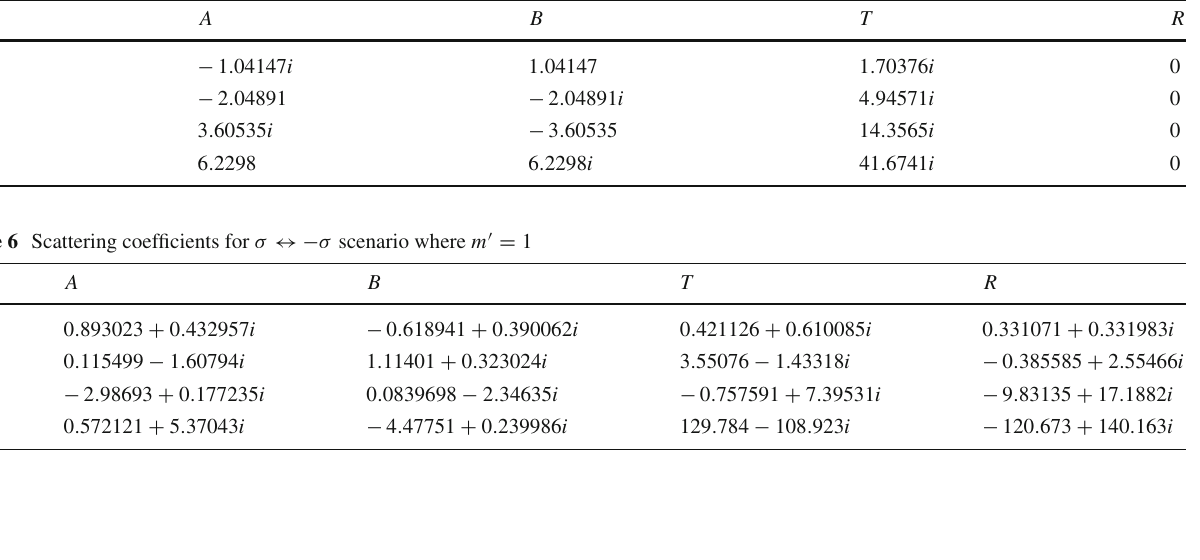
Fig. 4 The m (cid:2) -dependence of the transmission coefficient T and reflection coefficient R in the scattering with nonzero m (cid:2) scenario Table 5 Scattering coefficients for the spin-flip σ ↔ − σ scenario where m (cid:2) = 0